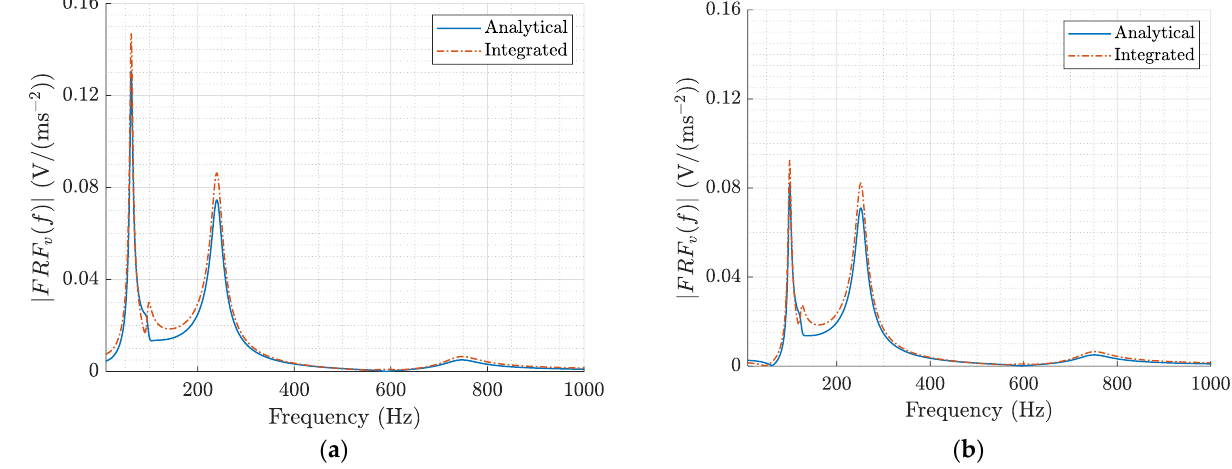
Figure 14. Comparison between the magnitudes of the OCV FRFs obtained using the analytical and integrated models. ( a ) k x = 0 Nm − 2 ; ( b ) k x = 10 6 Nm − 2